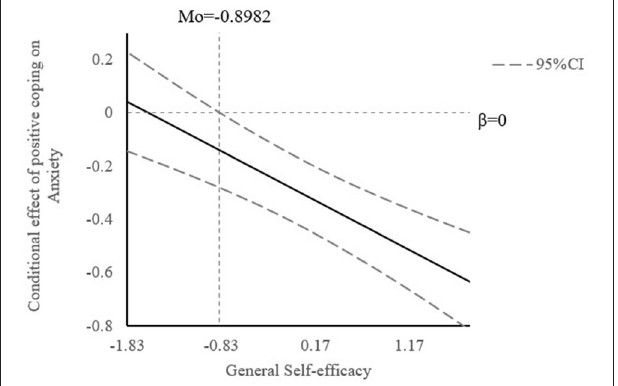
FIGURE 2 | The conditional effect of positive coping on anxiety at the value of general